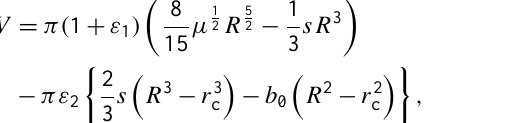
Figure 3. Sensitivity of equilibrium solutions of DAIS model ice volume to Antarctic temperature ( T a ) and sea level (SL). Solutions for the original (but corrected) Oerlemans (2005) model and stan- dard parameter values (Table 1; case 1 in Table 2) (a) . Solutions for a preferred model configuration (case 4 of Table 2) that also includes sensitivity to high-latitude, ocean subsurface temperature ( T o ) as calculated from Eq. (15) (b) . The black crosses mark solu- tions for present-day T a , SL and T o (Table